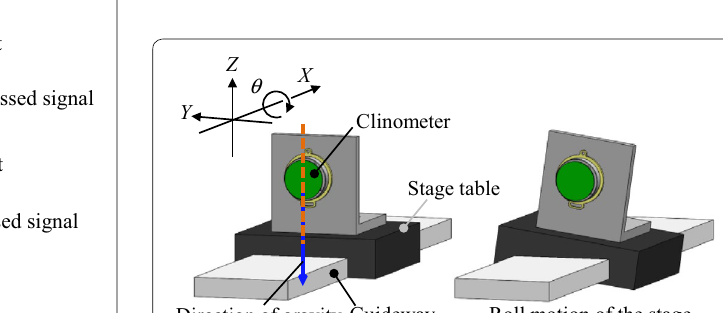
Figure 3 A timing chart of the signals from the trigger pulse generator and the one‑shot timer